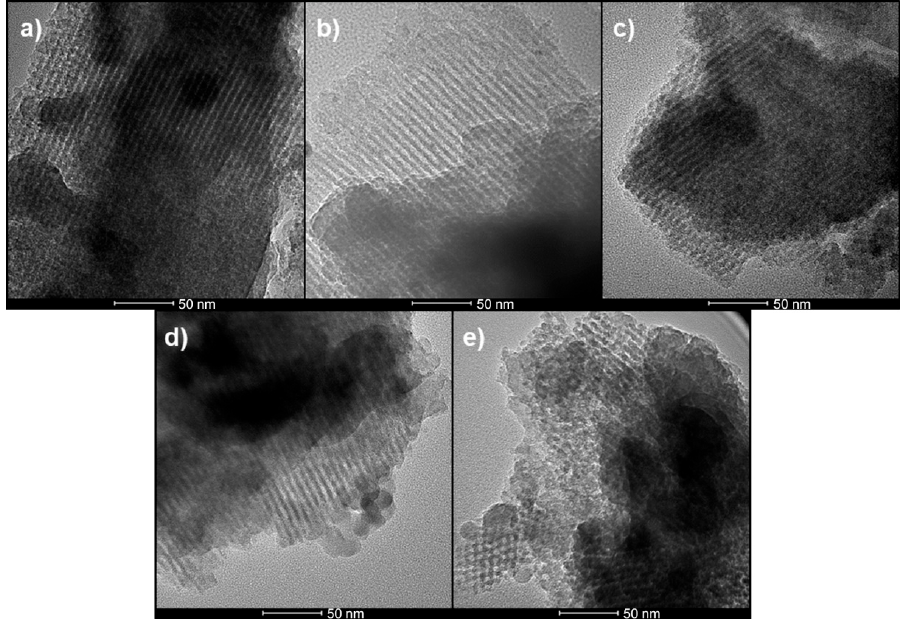
Figure 2. HRTEM images of ordered MSGs: ( a ) Undoped-MSG; ( b ) 5 wt% Ag-MSG; ( c ) 5 wt% Cu-MSG; ( d ) 5 wt% Zn-MSG; ( e ) 5 wt% Ce-MSG. Scale bar = 50